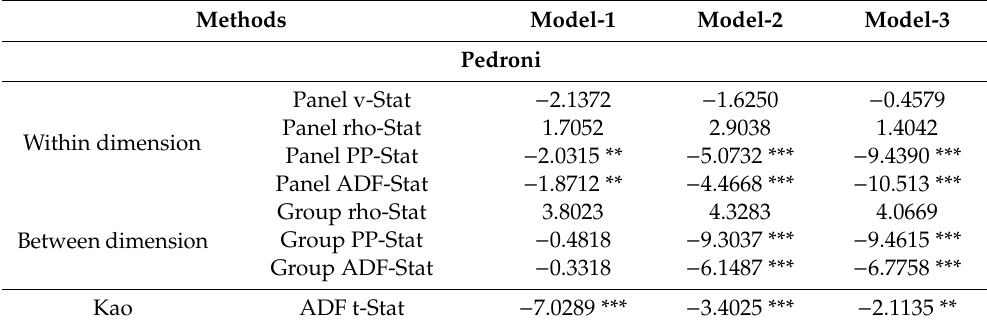
Table 5. Panel Co-integration